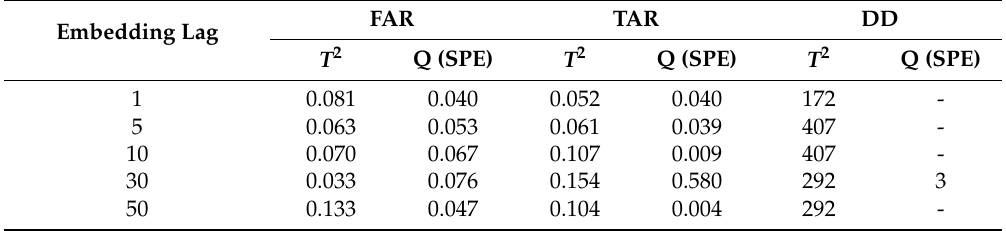
Table 5. Monitoring results on simulated dataset using Method III with embedding dimension of four. Embedding